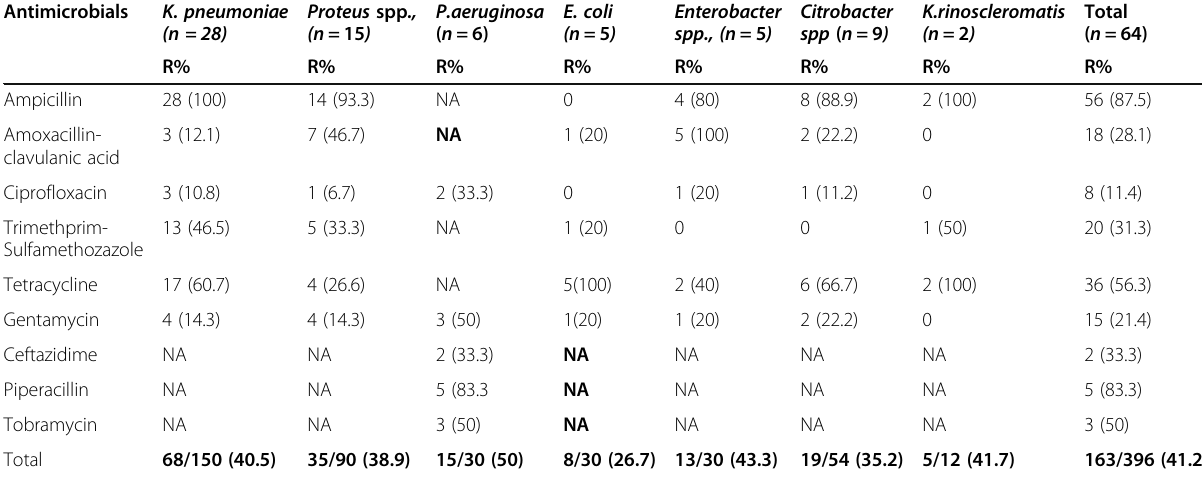
Table 5 Antimicrobial resistance profiles of Gram negative isolates from external ocular infections at Felege Hiwot Referral Hospital, 2019